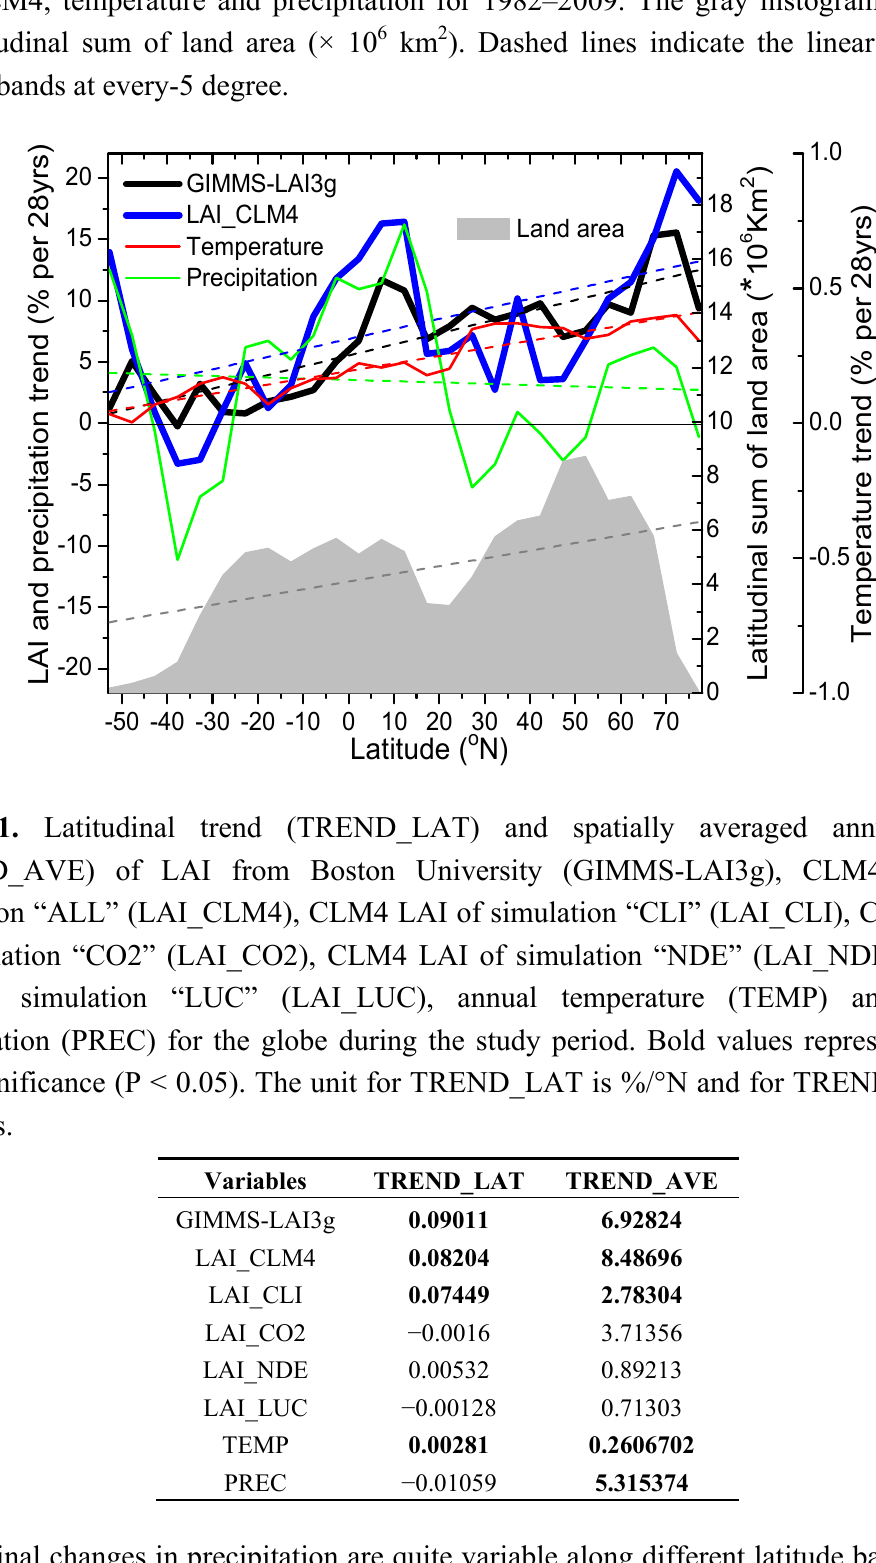
Figure 1. Latitudinal gradient of percentage change (%/28 yr) in GIMMS-LAI3g, LAI_CLM4, temperature and precipitation for 1982–2009. The gray histogram indicates the latitudinal sum of land area (× 10 6 km 2 ). Dashed lines indicate the linear fit to the latitude bands at every-5 degree.